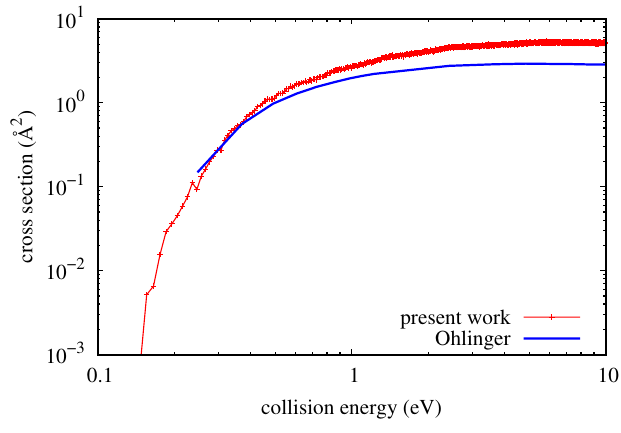
Figure 4. Dissociation cross-section for He + H 2 ( v = 7, j = 20) collisions, calculated by QCT (this work) and by approximated QM